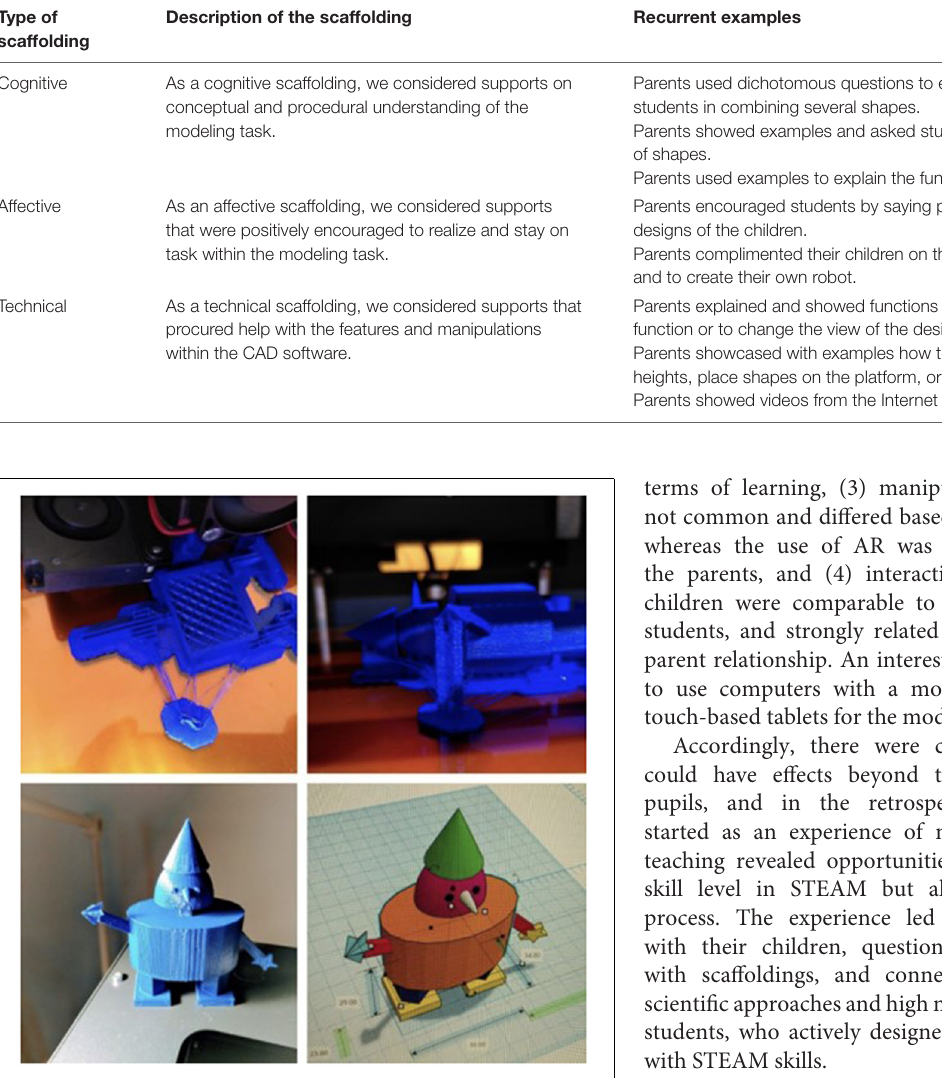
FIGURE 7 | Printing result and